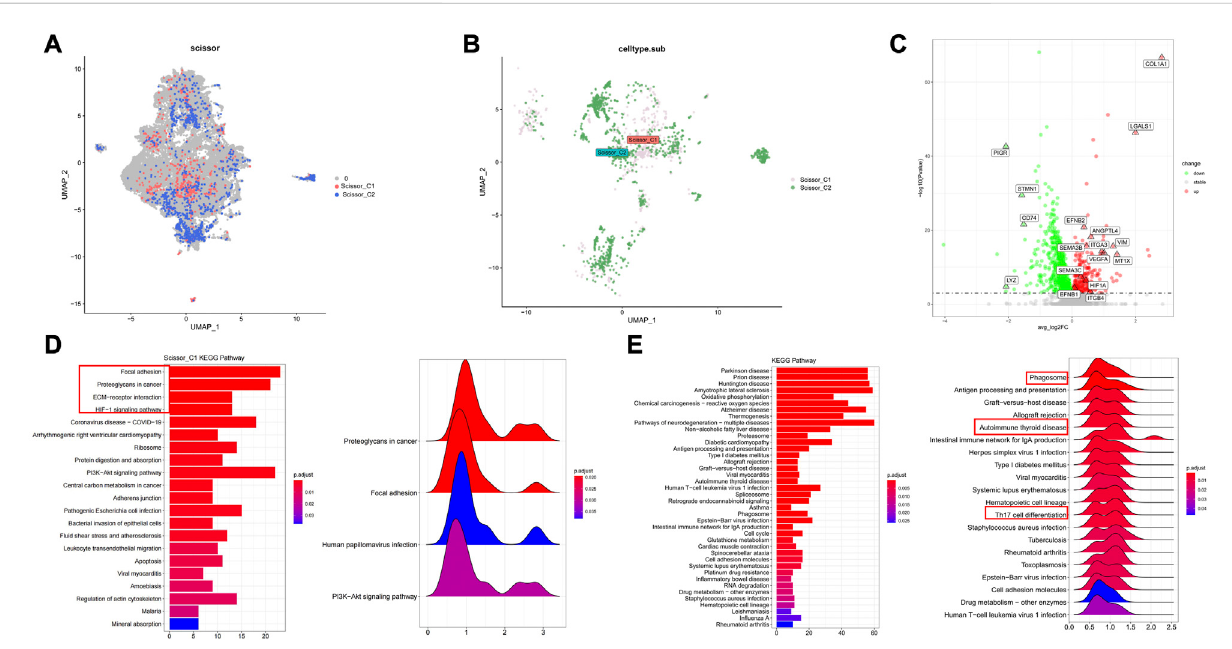
FIGURE 4 Characterization of two groups of Scissor epithelial cells (A,B) The Scissor algorithm identi fi es the two epithelial cells most associated with the two immune subtypes, Scissor_C1 and Scissor_C2 cells. (C) Scissor_C1 signi fi cantly up- and downregulated genes. (D) KEGG and GSEA enrichment analysis of Scissor_C1 revealing hypoxia and EMT related biological processes (Focal adhesion, ECM-receptor interaction and HIF-1 signaling pathway. (E) Revealing Scissor_C2 enrichment in oxidative phosphorylation and immune activity related pathways (antigen presentation, Th17 cell differention).